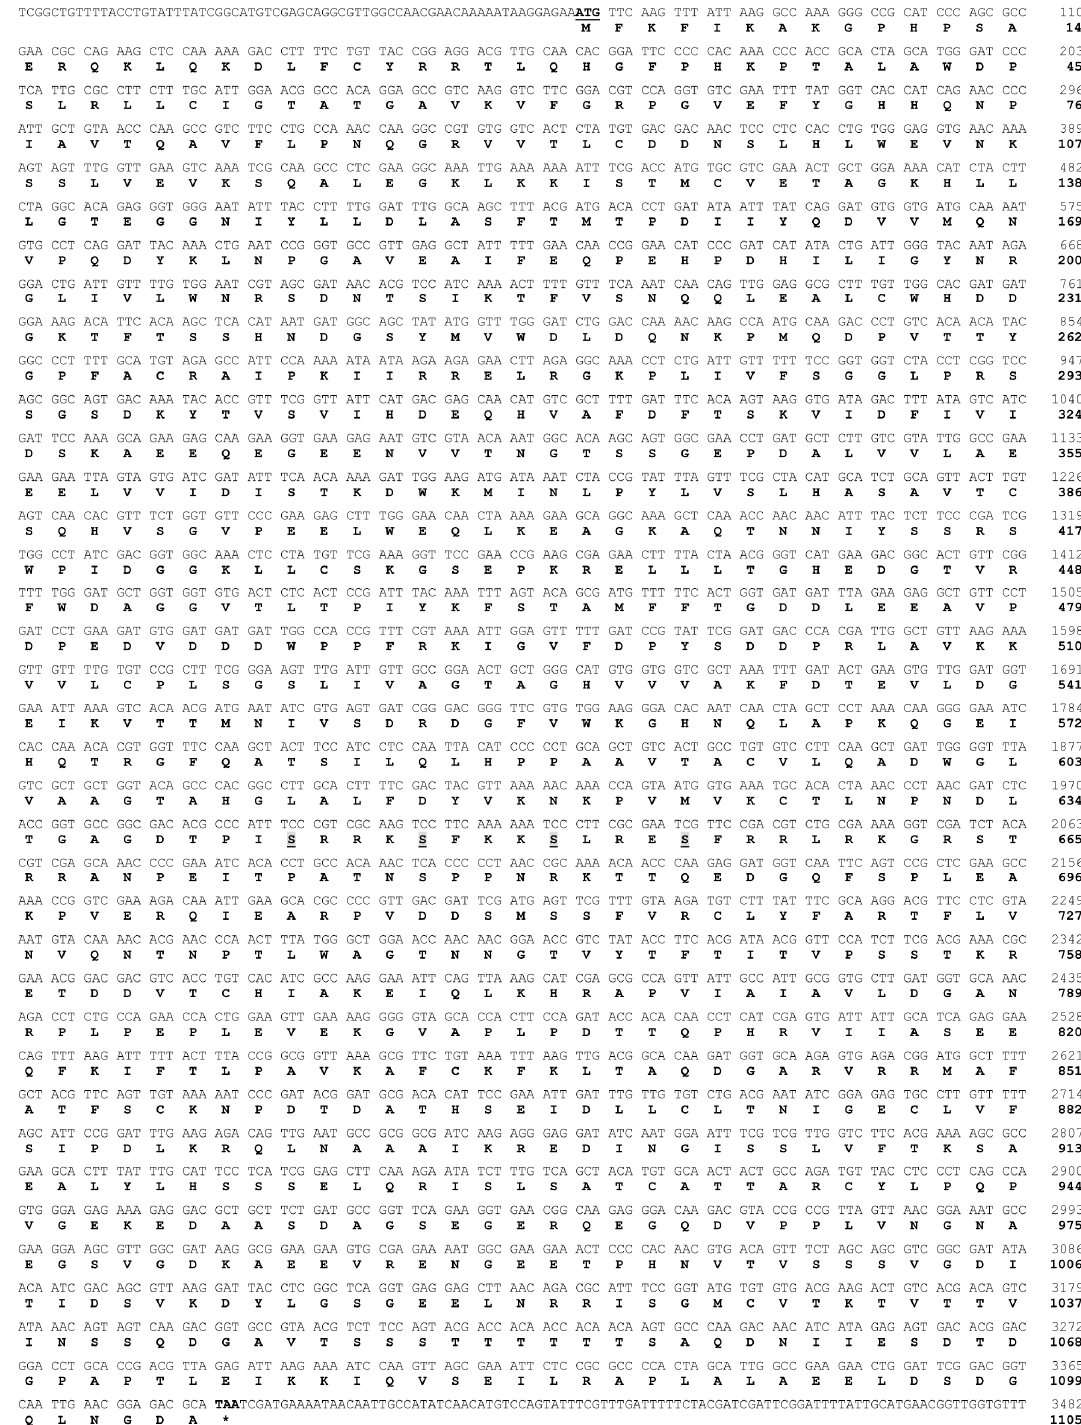
Figure 1. The cDNA and deduced amino acid sequences of Lgl gene from T. castaneum . The amino acid sequence is numbered from the start of its predicted mature protein. The start codon ATG is bolded and underlined, and the stop codon TAA at the end of the coding region is bolded and marked with an asterisk. The conserved serine phosphorylation sites of the deduced amino acid sequence are bolded and underlined. Both the cDNA and deduced amino acid sequences have been deposited in GenBank (accession numbers: